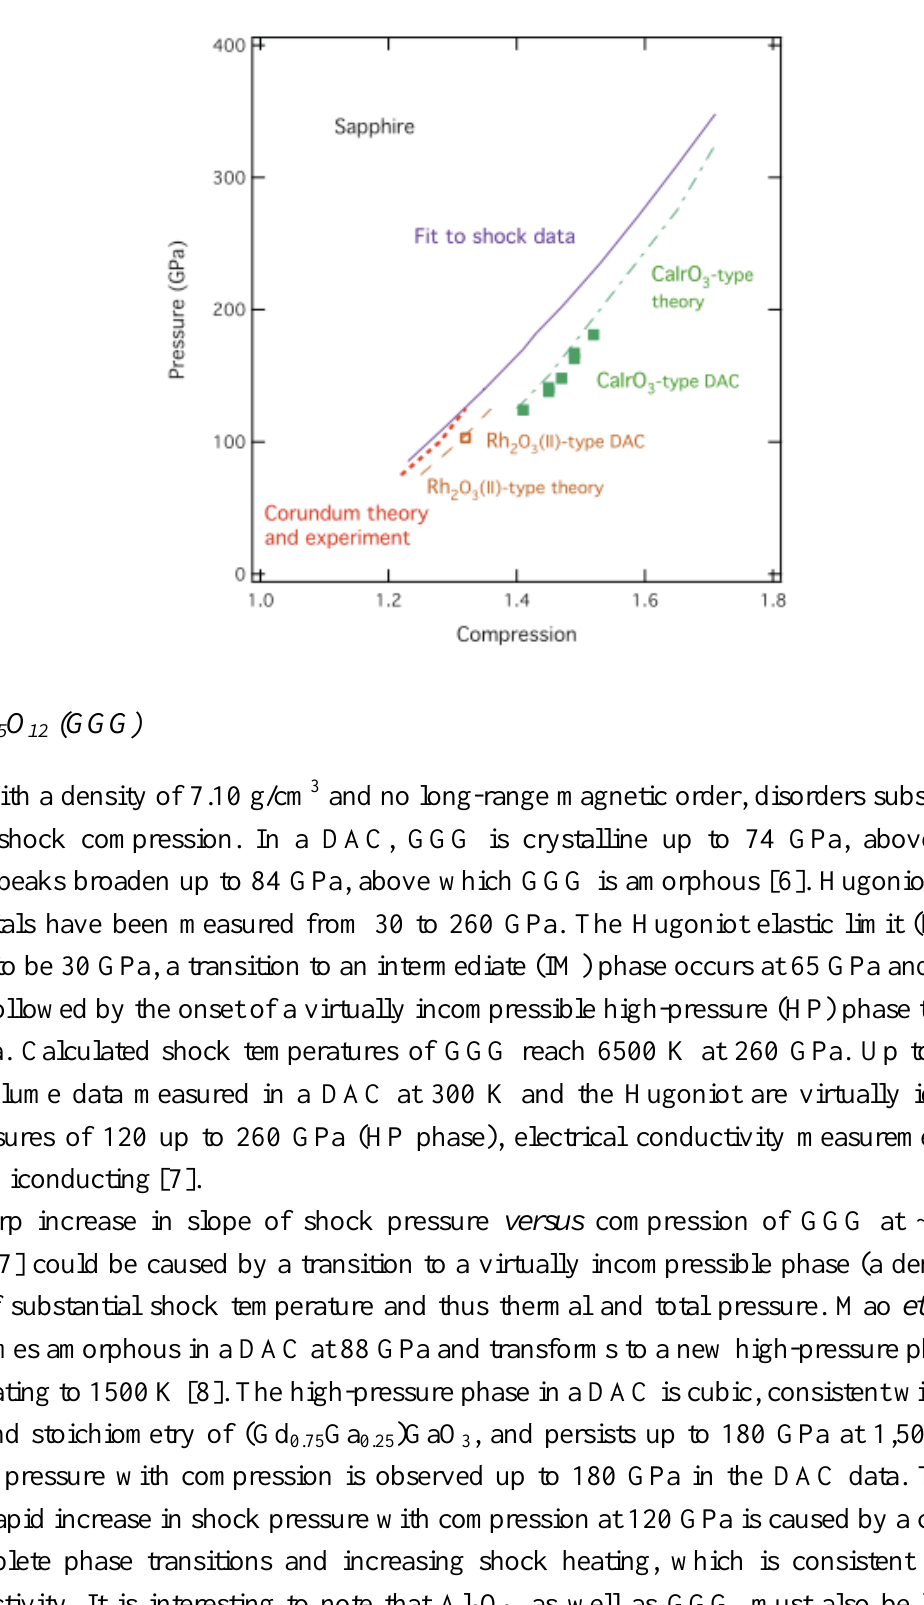
Figure 5. Pressure versus compression on shock Hugoniot [33], DAC data on 300-K isotherm [5], and theory [34] for Al